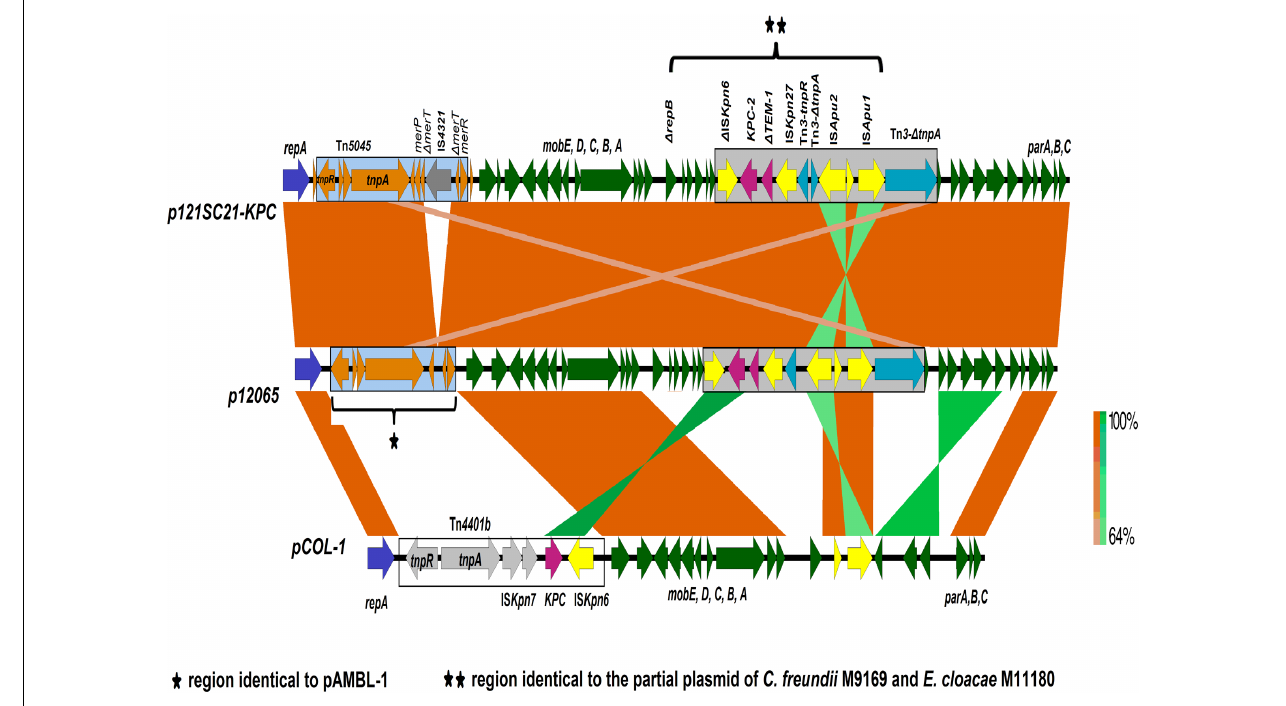
FIGURE 2 | Structure comparison of the p121SC21-KPC2 with p12065 and pCOL-1. Genes (open reading frames) and their corresponding transcriptional orientations are indicated by broad horizontal arrows. The orange- and green-shaded areas show identical regions among the structures compared, in the same orientation or inverted,